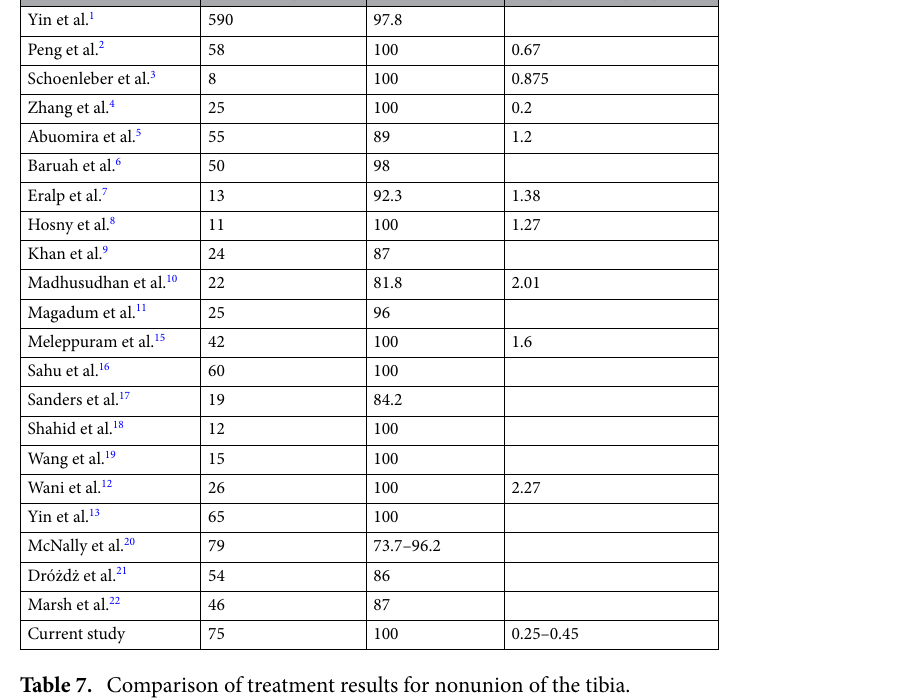
Table 7. Comparison of treatment results for nonunion of the